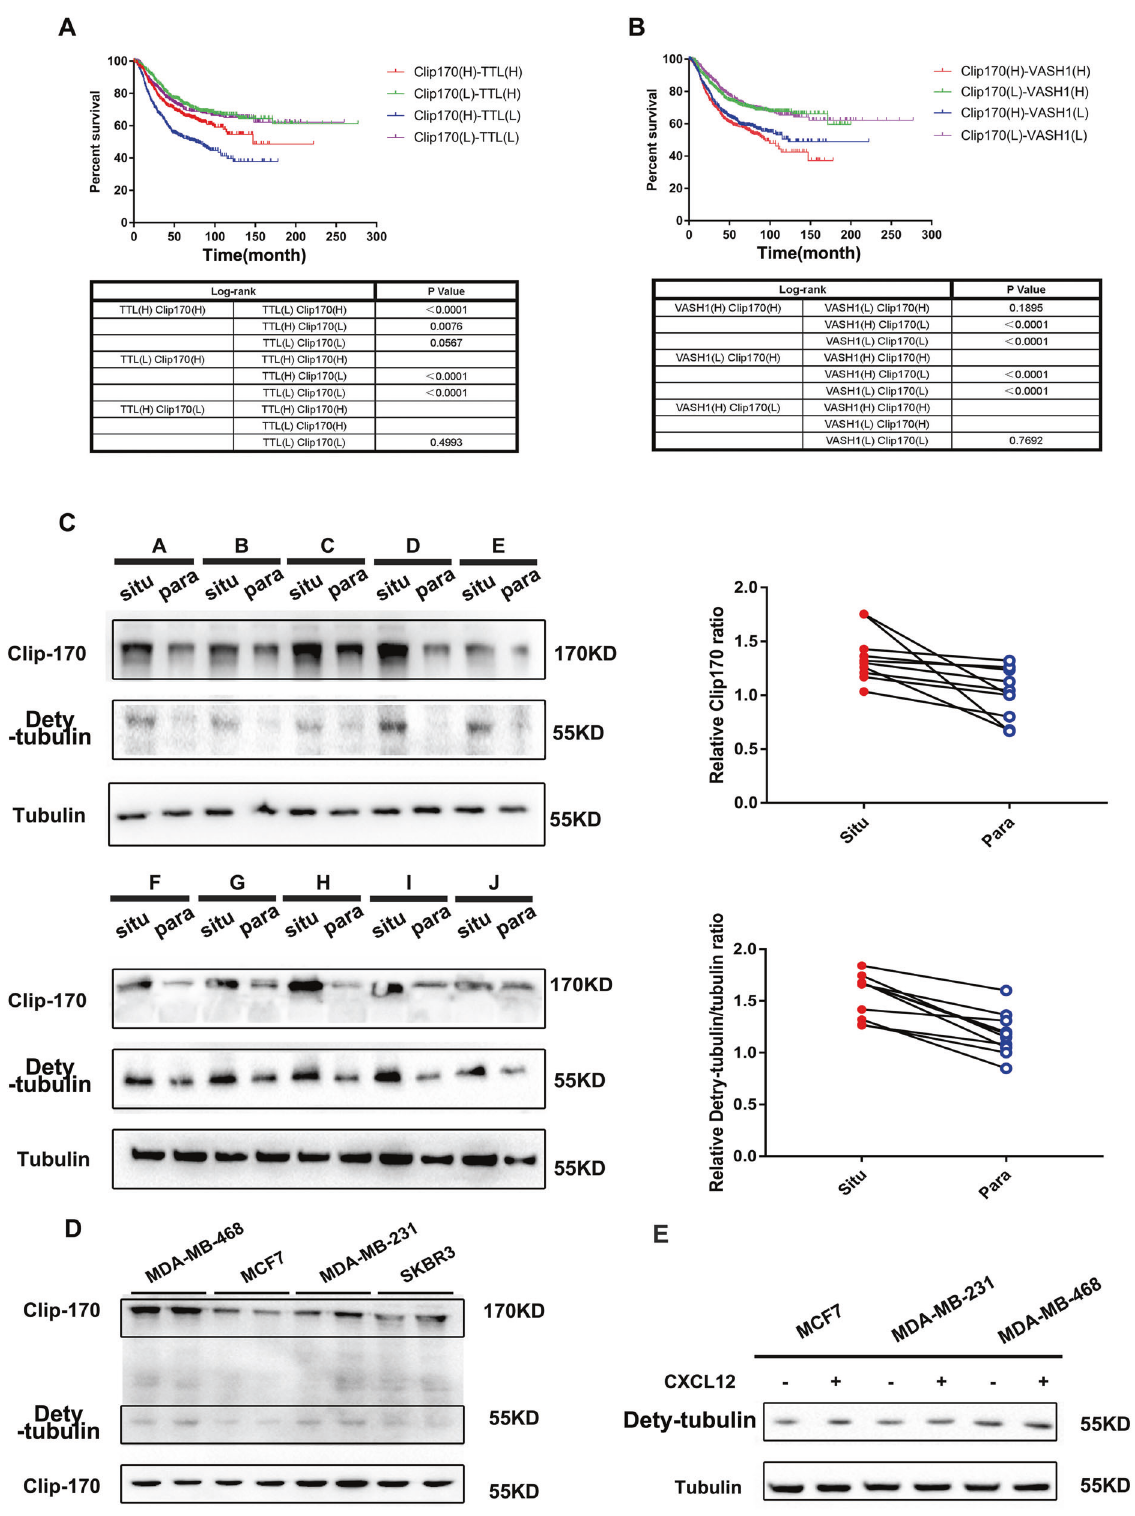
Fig. 3 Association between Clip170 and α -tubulin detyrosination levels with prognosis and aggressiveness in breast cancer. A Kaplan – Meier plots of the overall survival of patients with breast cancer, strati fi ed by Clip170 and TTL expression. B Kaplan – Meier plots of the overall survival of patients with breast cancer, strati fi ed by Clip170 and VASH1 expression. C Left panel: Western blotting analysis of Clip170 and detyrosinated-tubulin levels in fresh breast cancer tissue (situ) and adjacent normal tissue (para). Right panel: Quantitative analysis of Clip170 and detyrosinated-tubulin levels in breast cancer tissues and matched normal tissues ( n = 10). D Western blotting analysis of Clip170 and detyrosinated-tubulin levels in MDA-MB-231, MDA-MB-468, MCF7, and SKBR3 cells. E Western blotting analysis of detyrosinated-tubulin levels in MDA-MB-231, MDA-MB-468, and MCF7 cells after CXCL12 treatment.